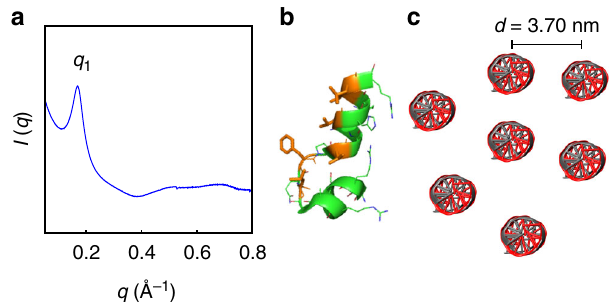
Fig. 4 Structure of buforin-double-stranded DNA (dsDNA) complexes. a Representative small-angle X-ray scattering (SAXS) data of an isoelectric buforin-dsDNA complex. One main diffraction peak is observed at q 1 = 0.170 Å − 1 with weak broad features at higher q , consistent with a disordered columnar structure with short-ranged order. b Structure of the buforin monomer (taken from the H2A histone, PDB: 4KGC 60 ). See Supplementary Discussion for details regarding the relationship between buforin and H2A. c Illustration of the buforin-dsDNA columnar lattice with average inter-dsDNA spacing of d = 3.70